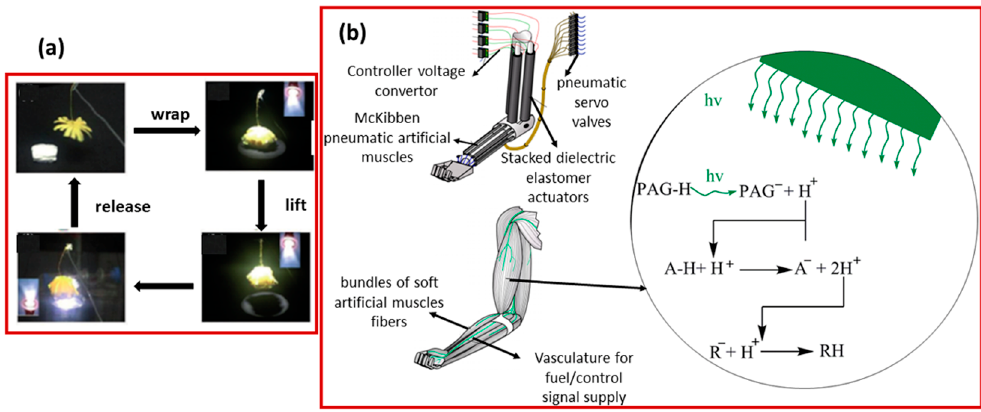
Figure 9. ( a ) BA2DA-PVDF robot with multiple arms grasping objects (Reprinted (adapted) with